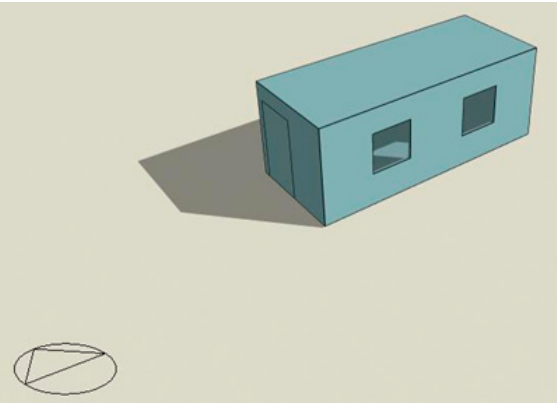
Figure 15. DesignBuilder render of the shelter.